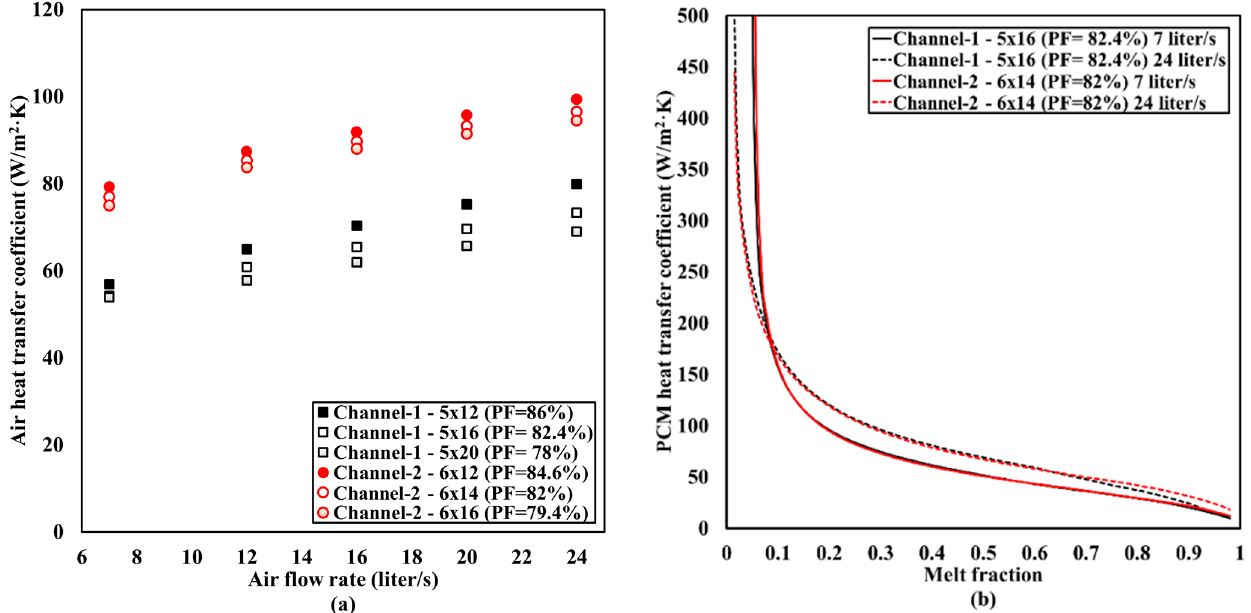
Figure 11. ( a ) mean air heat transfer coefficient during melting, ( b ) transient heat transfer coefficient on the PCM side during melting.